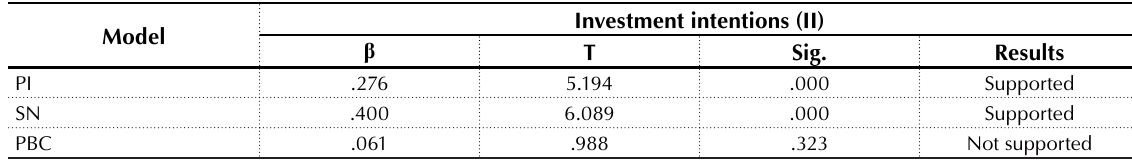
Table 3. The structural model path coefficient